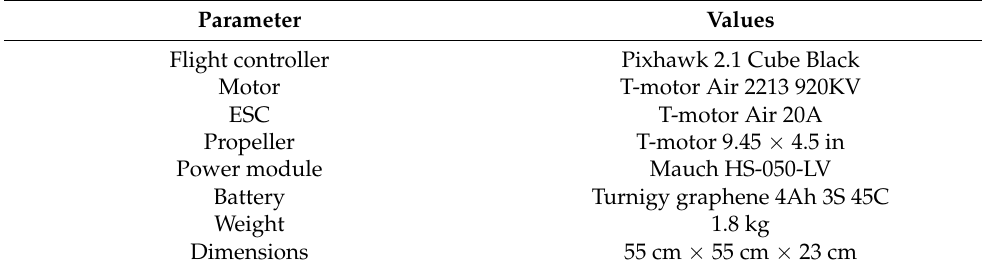
Figure 9. Hexarotor UAV used as the case study for the estimation of the required energy. Table 1. Hexarotor specifications.